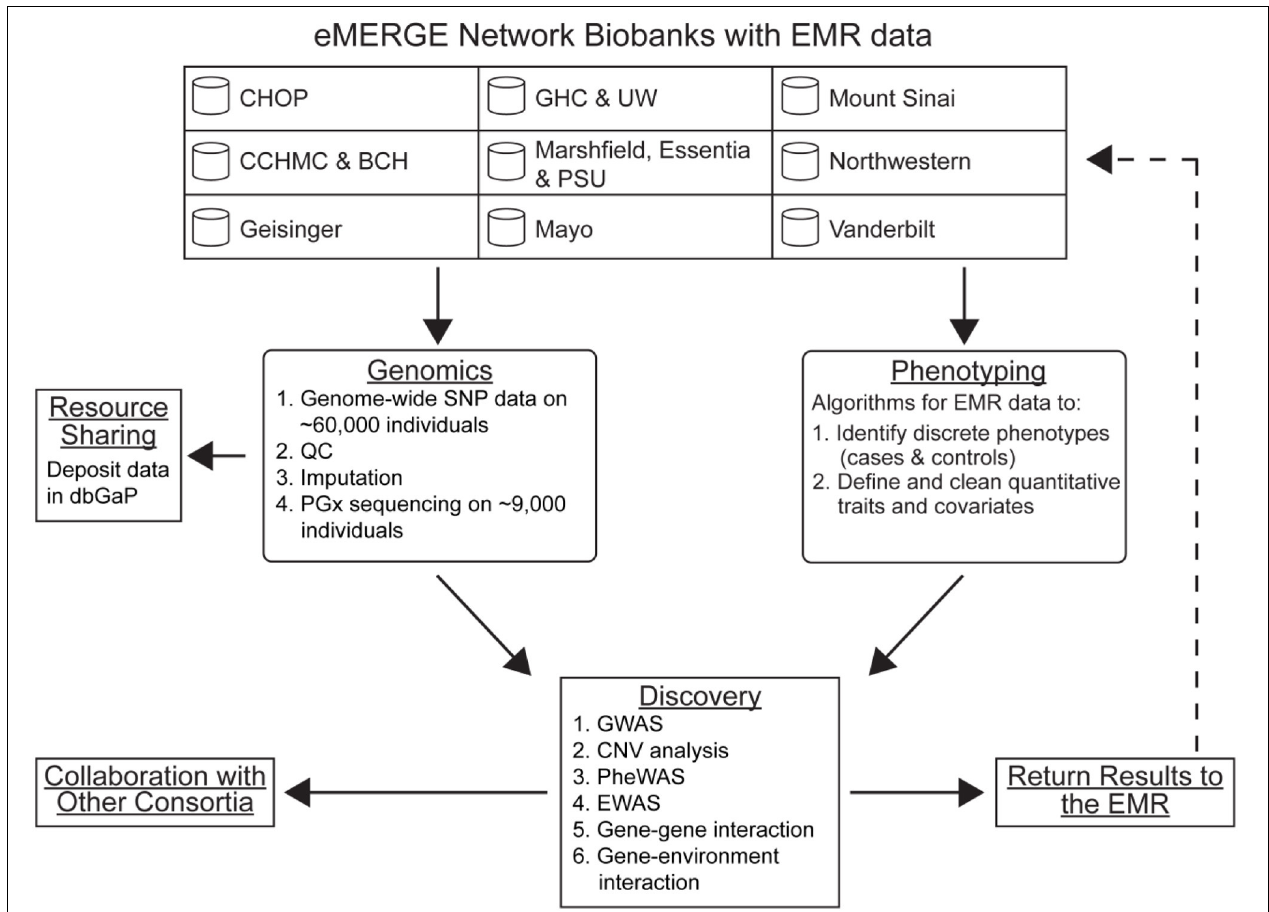
FIGURE 1 | Major activities of the Genomics Work Group of the eMERGE network. Abbreviations: CHOP, Children’s Hospital of Philadelphia; CCHMC, Cincinnati Children’s Hospital Medical Center; BCH, Boston Children’s Hospital; GHC, Group Health Cooperative; UW, University of Washington;